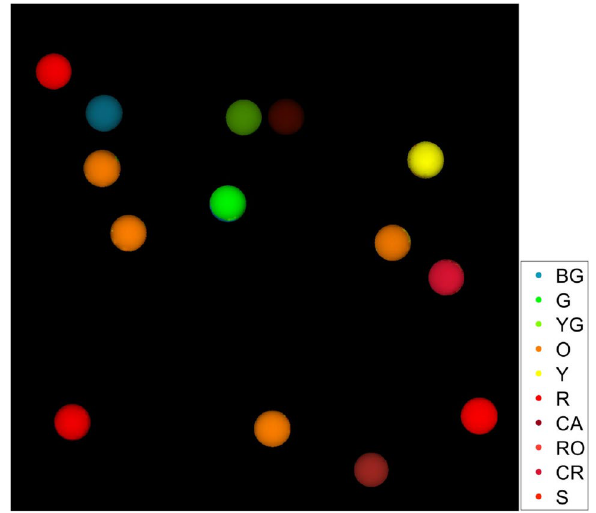
Figure 11. Synthesized image of 10 types of fluorescent beads using classification predictions by the convolutional neural network with N=100 non He-Ne corrected interferograms at each